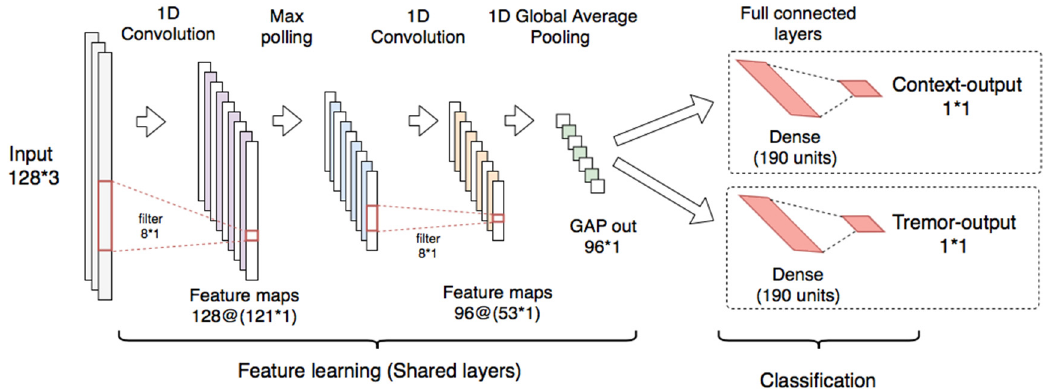
Figure 8. Multitask CNN used for the context classifier and the tremor classifier using raw signals.